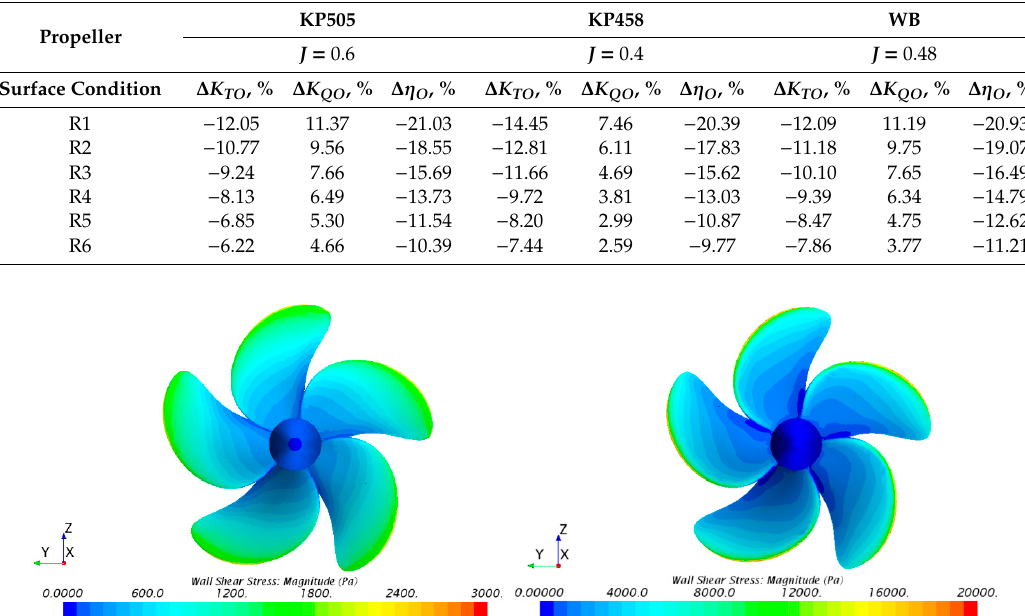
Figure 10. The impact of hard fouling (R1) on KP505 ( upper ), KP458 ( middle ) and WB ( lower ) performance in OWT. Table 13. The obtained changes in K TO , K QO and η O due to the presence of hard fouling. Propeller